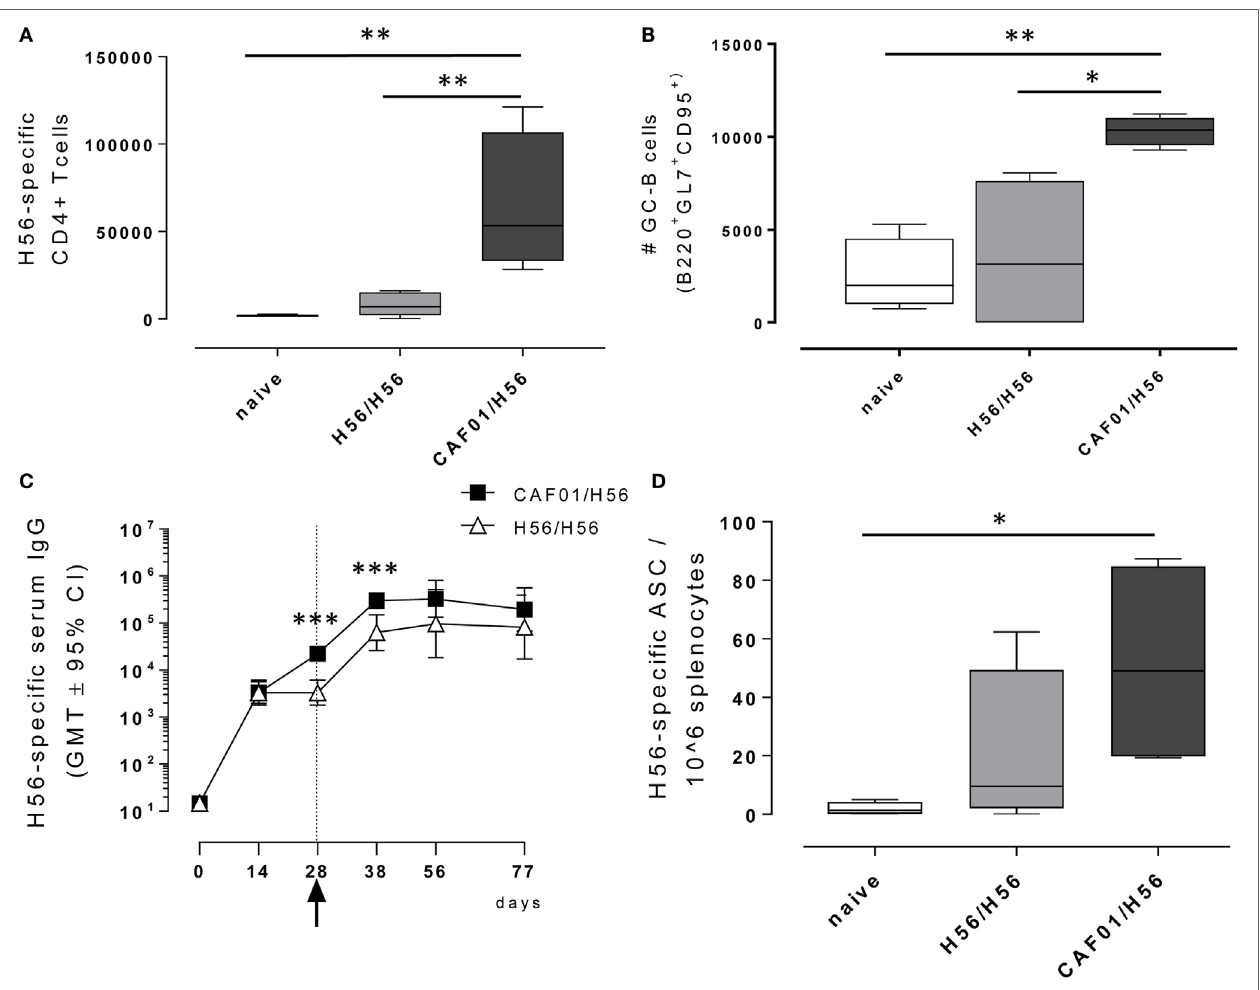
FigUre 2 | Adaptive immune response following booster immunization. C57BL/6 mice were subcutaneously immunized as reported in Figure 1 . dLN were collected 10 days after booster immunization and analyzed for the T and B recall responses. (a) Number of Ag-specific CD4 + T cells, identified as CD4 + CD44 + tetramer Ag85B-specific cells. Mean values ± SEM of five mice per group are reported. (B) Number of germinal center B cells, identified as GL7 + CD95 + among B220 + B cells in dLN. (c) H56-specific serum IgG titers determined on days 0, 14, 28, 38, 56, and 77 following priming, by ELISA. Antibody titers values are reported as GMT ± 95% CI of five mice per group. Arrow indicates day 28 that is the time of boosting. (D) H56-specific antibody-secreting cells (ASC) detected in spleens by ELISPOT assay. Kruskal–Wallis test was used to assess statistical differences between groups of mice primed with H56 + CAF01 versus H56 alone (* P ≤ 0.05, ** P ≤ 0.01, and *** P ≤